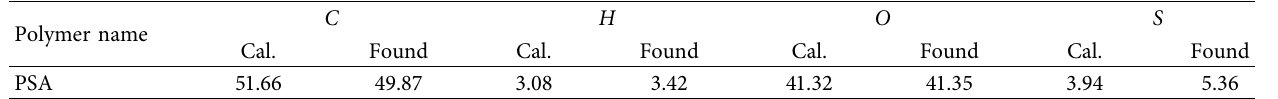
Table 3: Elemental analytical data of the prepared